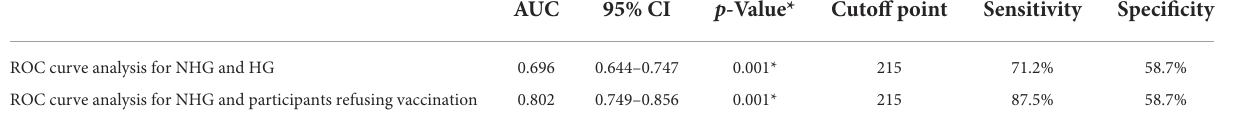
TABLE 3 ROC curve analysis results of vaccine hesitancy